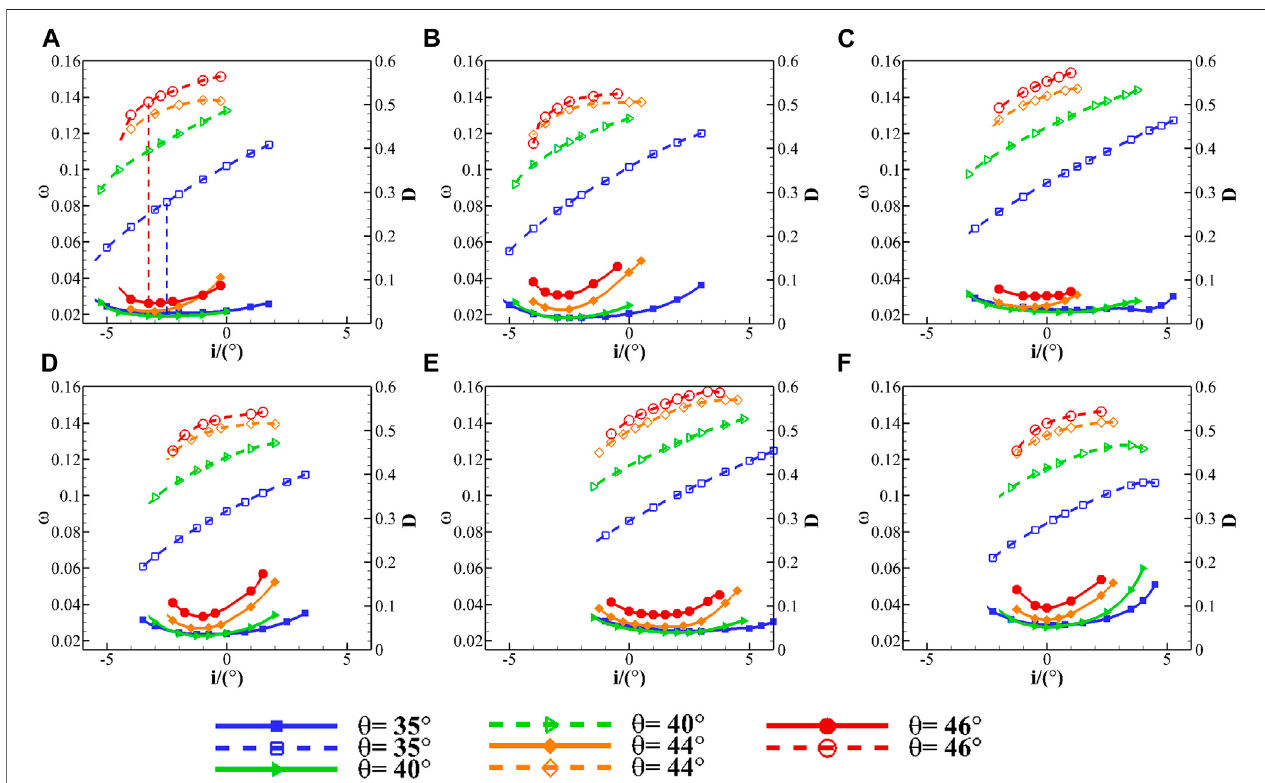
FIGURE 8 | In fl uence of camber angles on incidence characteristics of total pressure loss coef fi cient and diffusion factor (A) e/b (cid:1) 0.2, σ (cid:1) 1.25; (B) e/b (cid:1) 0.6, σ (cid:1) 1.25; (C) e/b (cid:1) 0.2, σ (cid:1) 1.67; (D) e/b (cid:1) 0.6, σ (cid:1) 1.67; (E) e/b (cid:1) 0.2, σ (cid:1) 2.05; (F) e/b (cid:1) 0.6, σ (cid:1) 2.05.